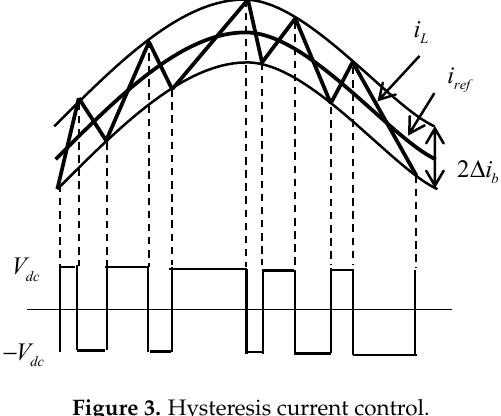
Figure 3. Hysteresis current control.